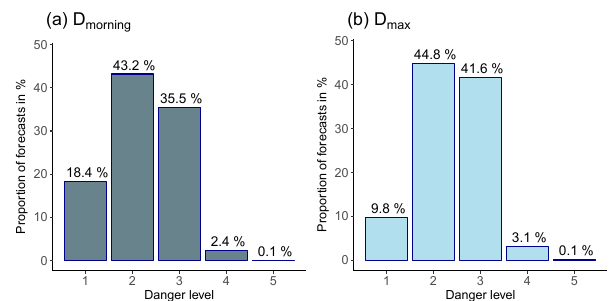
Figure 4. Distribution of forecast danger levels, for (a) D morning (danger level valid during first time step) and (b) D max (highest danger level). Mean values are shown for all the warning regions in the Alps taken